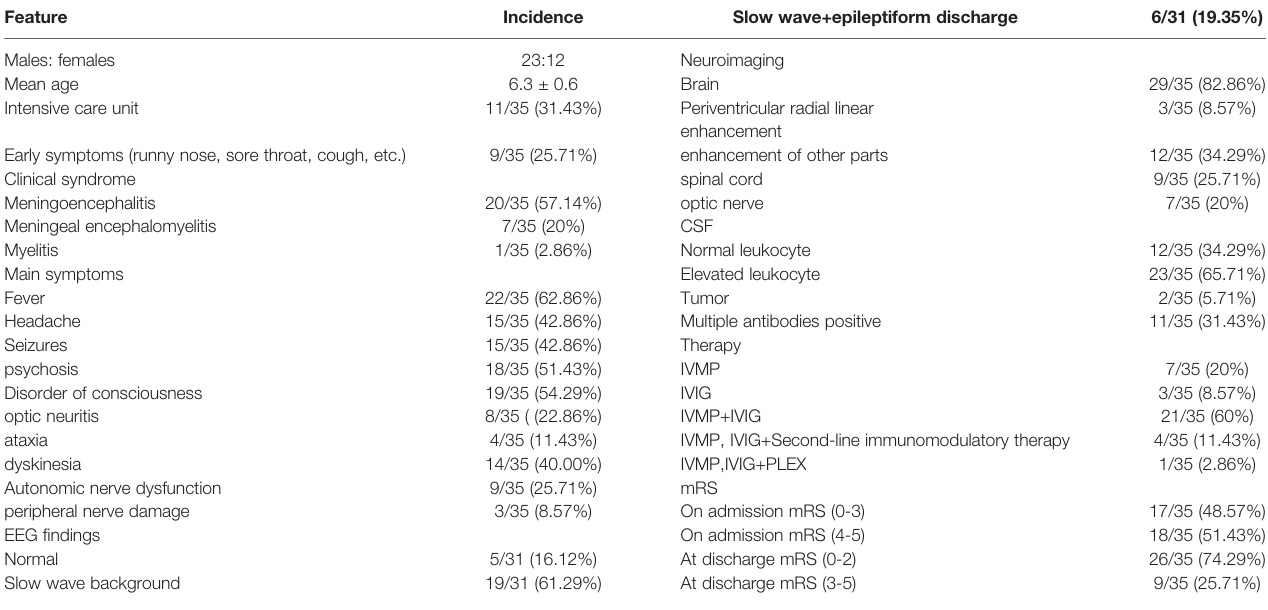
TABLE 2 | Summary of clinical syndromes and associated conditions in patients with GFAP Astrocytopathy. Feature